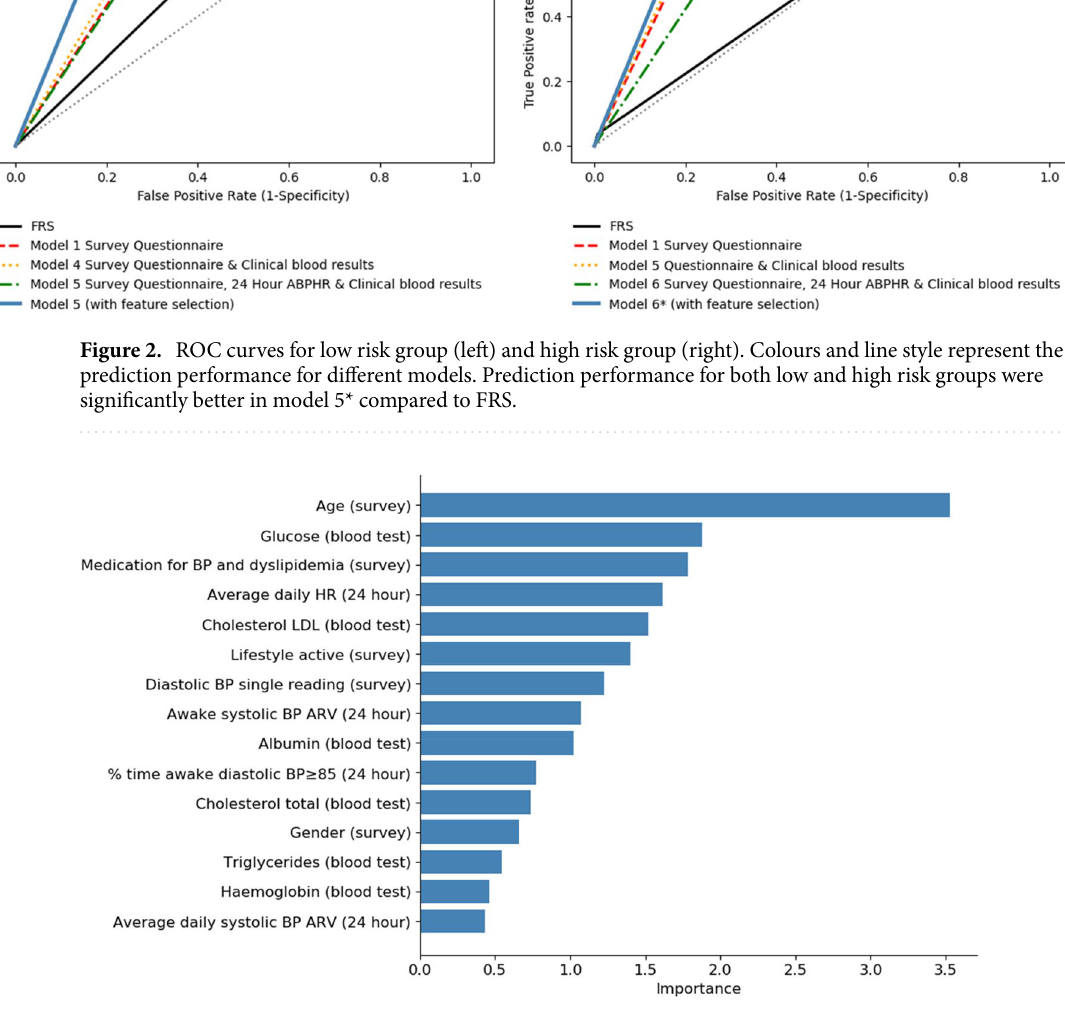
Figure 3. The top 15 features of MLA models showing the relative importance of the different variables in CVD risk prediction. Age, glucose, cholesterol LDL, wake period blood pressure variability, medication for BP and dyslipidemia, triglycerides and albumin reading were some common predictors across the different